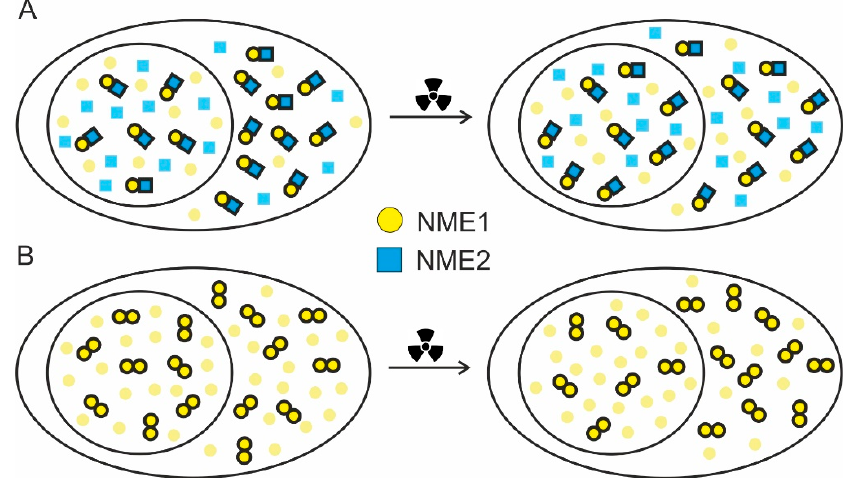
Figure 5 . Schematic interpretation of the changes in D F determined by FRET/FLIM experiments and shown in Figure 4. ( A ) Before irradiation, D F for fluorescently labelled NME1 and NME2 is significantly larger in the cytoplasm than in the nucleus, indicating more NME1/NME2 heteromers in the cytoplasm than in the nucleus. After irradiation, this difference is rendered insignificant. This panel corresponds to Figure 4A,B. ( B ) Before irradiation, D F for fluorescently labelled NME1 is not distinguishable between the cytoplasm and the nucleus. After irradiation, D F becomes significantly larger in the cytoplasm than in the nucleus, indicating more NME1 homomers in the cytoplasm than in the nucleus. This panel corresponds to Figure 4C,D. An equivalent interpretation applies to Figure 4E,F, corresponding to oligomerization of NME2. Oligomerization state of NME proteins is simplistically shown as being either dimeric or monomeric, whereas in reality different hexameric configurations probably dominate. In both panels, the differences between the cytoplasm and the nucleus are exaggerated for clarity.